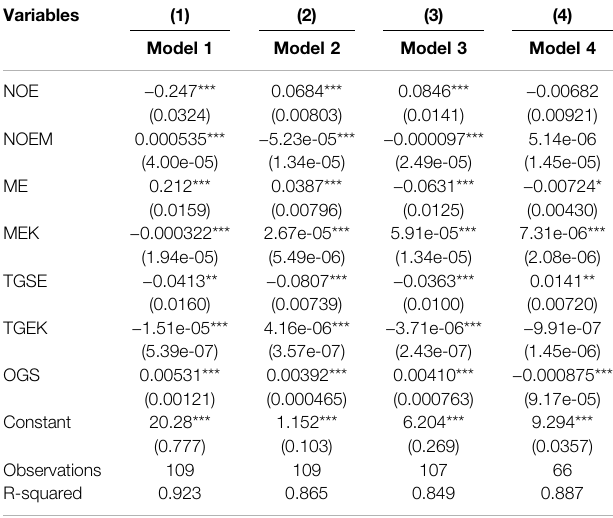
TABLE 2 | Climate extreme and agriculture dynamics under OLS estimation. Variables